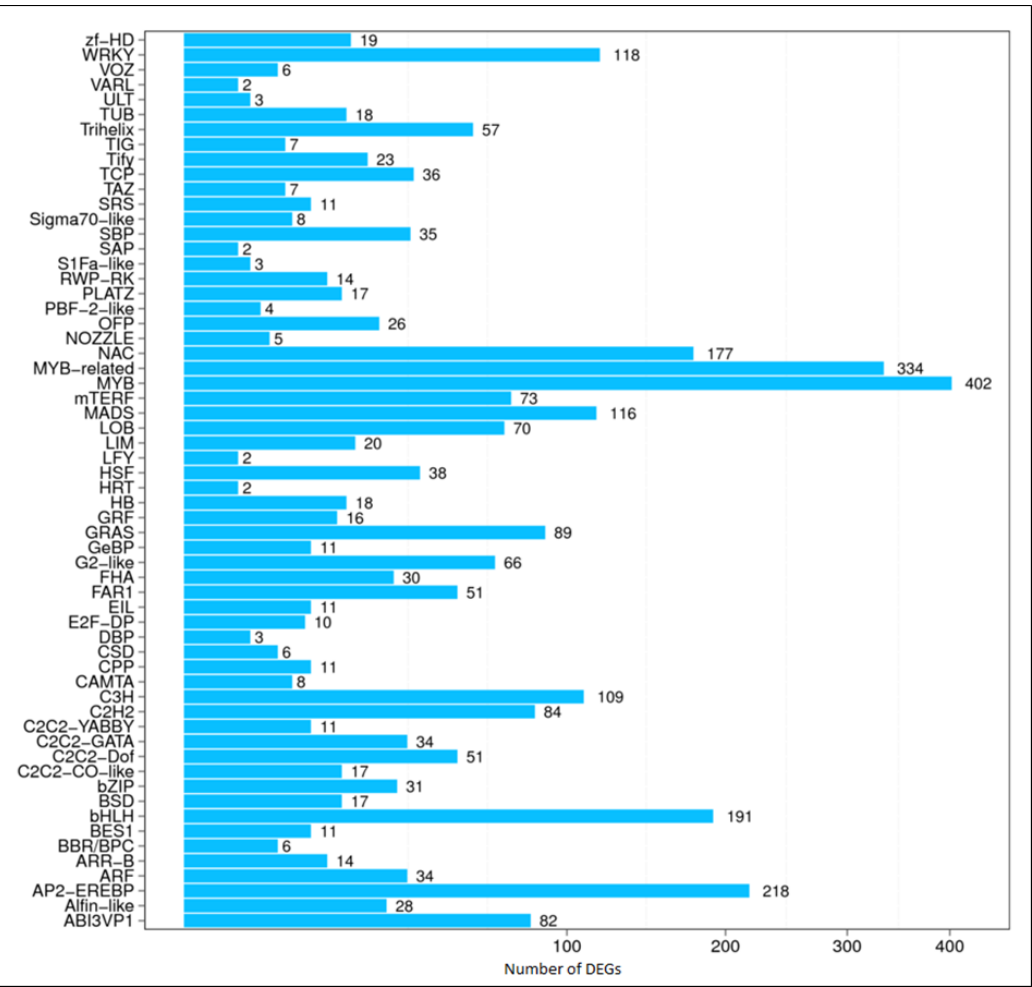
Figure 6. Transcription factor family classification of all DEGs.